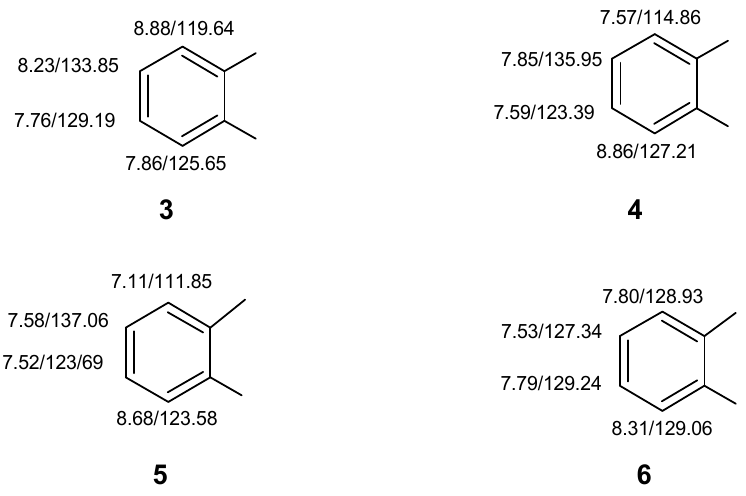
Figure 9. 13 C and 1 H chemical shift assignments of four-spin systems 3 – 6.